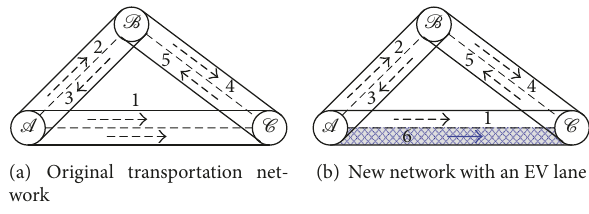
Figure 1: A three-node network for the running example. Table 1: Results of three design schemes in the running